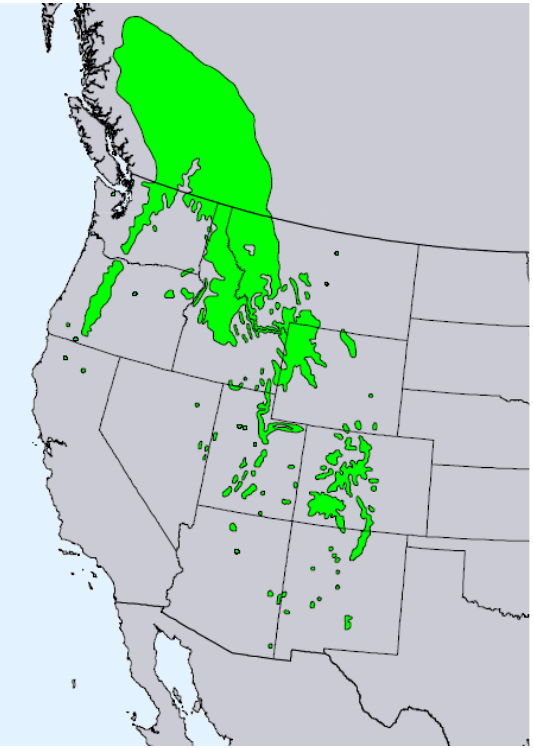
Figure 3. Natural range of Picea engelmannii [6].